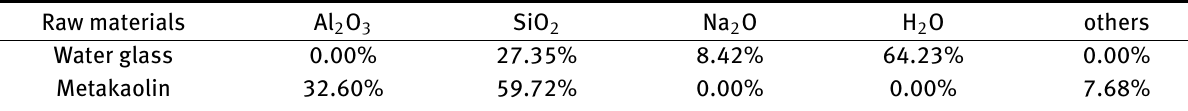
Table 1: Chemical composition of raw materials Raw materials Al 2 O 3 SiO 2 Na 2 O H 2 O others Water glass 0.00% 27.35% Metakaolin 32.60% 59.72%